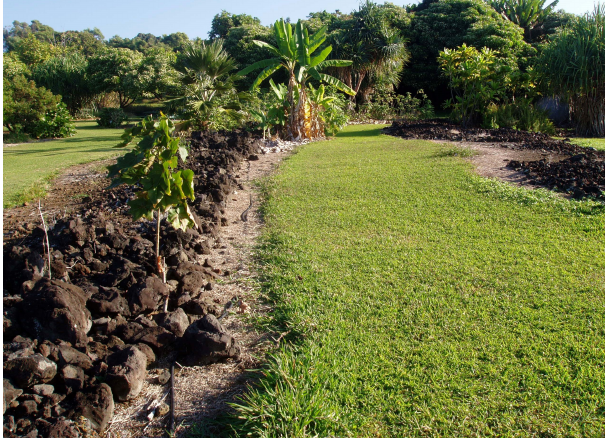
Fig. 4. The archaeological remains of a lithic berm ( kuaiwi ) in Kealakekua, Kona Hema, Hawai ʻ i. Such lithic berms were constructed to increase ecosystem services (e.g., moisture retention) and decrease ecosystem disservices (e.g., erosion) in intensified rain-fed agroecology. Photo by N. K.